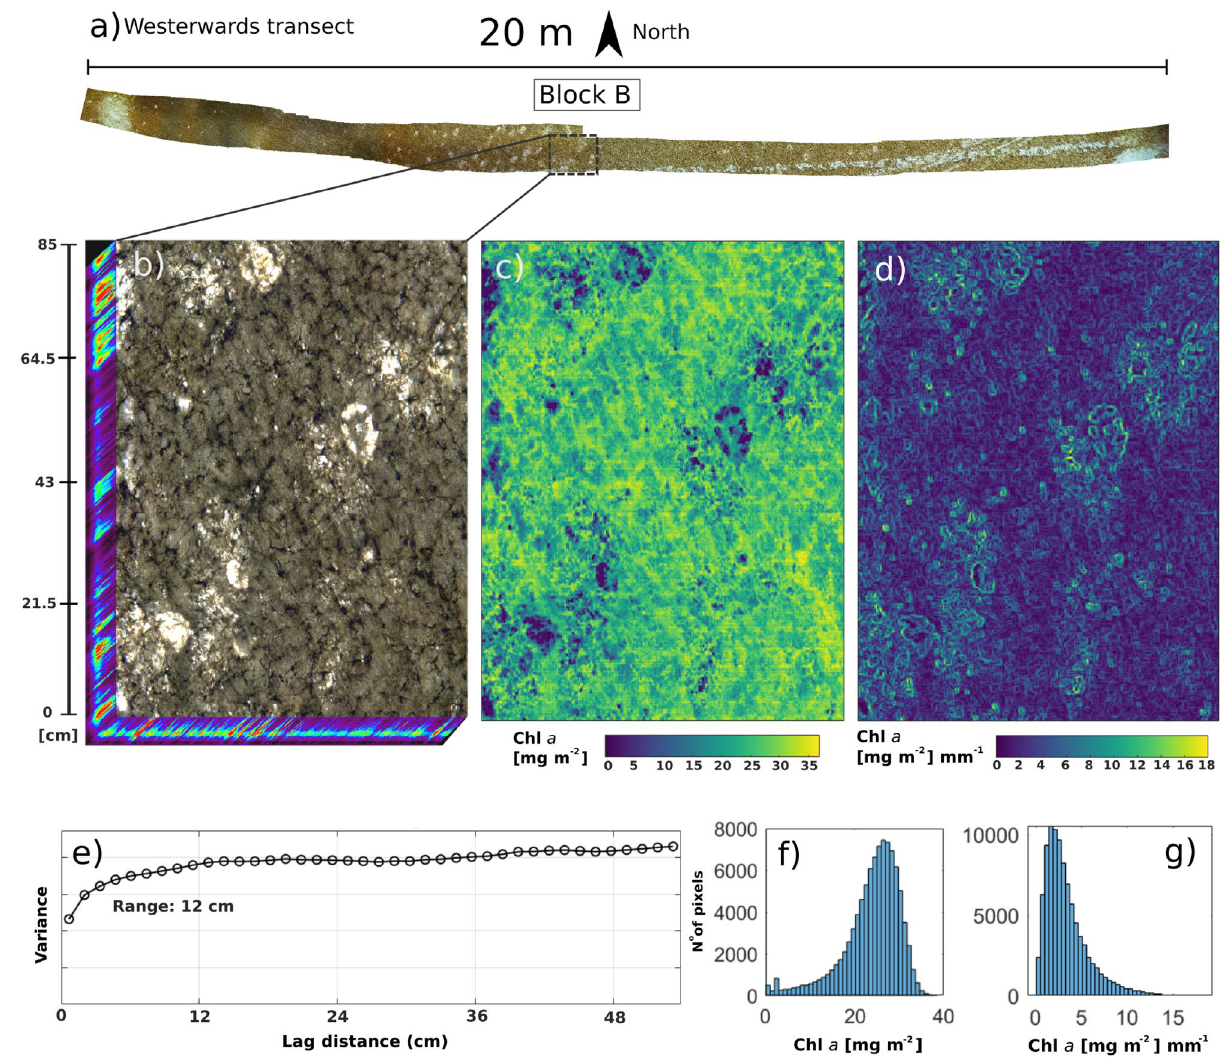
Figure 7. Application of best performing bio-optical regression model (LAUC) to the in situ under-ice imagery and associated microspatial analyses. ( a ) Framing of the block B hyperspectral image subsample within the entire 20 × 0.6 m transect provides an indication of the spatial scale. ( b ) A high-resolution HI data cube representation over block B which is 0.85 × 0.7 m in extent. ( c ) A quantitative mapping of Chl a by applying the LAUC index regression model on a per pixel basis to the pseudo-transmittance image of block B. Spatial resolution following a × 4 binning is 2.4 mm per pixel. ( d ) Magnitude of gradient of Chl a concentration derived from block B using a Prewitt kernel. ( e ) Empirical variogram of ice algal biomass computed by randomly sampling 10,000 pixels within the image and starting with a lag distance of 1.2 cm (5 pixels). Variances are shown in arbitrary units starting at zero. ( f ) Histogram of per-pixel Chl a estimates over entire block B shown in panel c ). ( g ) Histogram of per pixel gradient distributions relative to gradient map shown in panel d ). RGB composites of the under-ice hyperspectral imagery was produced using bands at wavelengths 647 nm, 554 nm and 462 nm